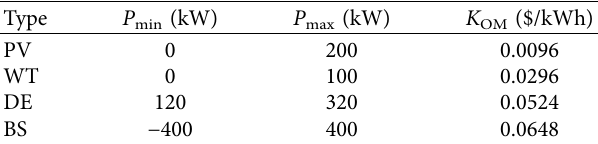
Table 1: Operating parameters of the microgrid system.